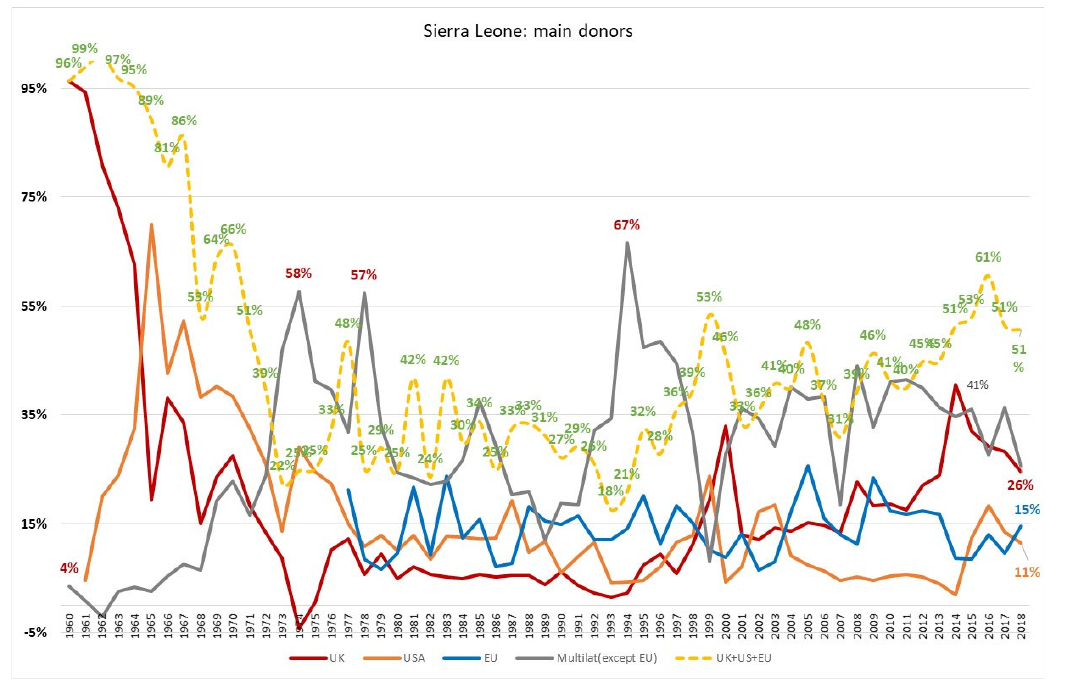
Figure 8. Main donors to Sierra Leone. Source: Authors’ elaboration with data from OECD ‐ DAC Table 2a: net ODA total net disbursements in constant USD, 2018.